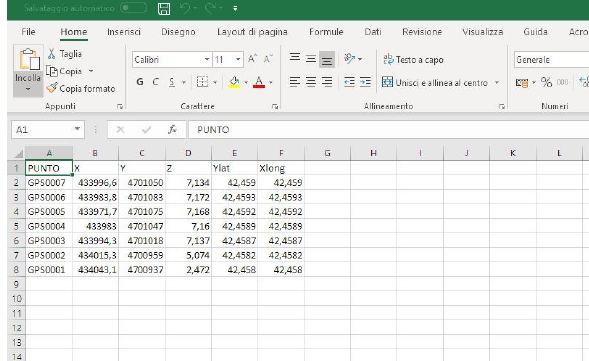
Figure 5: acquisition of 8 GPS certain points, coordinated in the workspace, necessary to have absolute measurements for comparison.